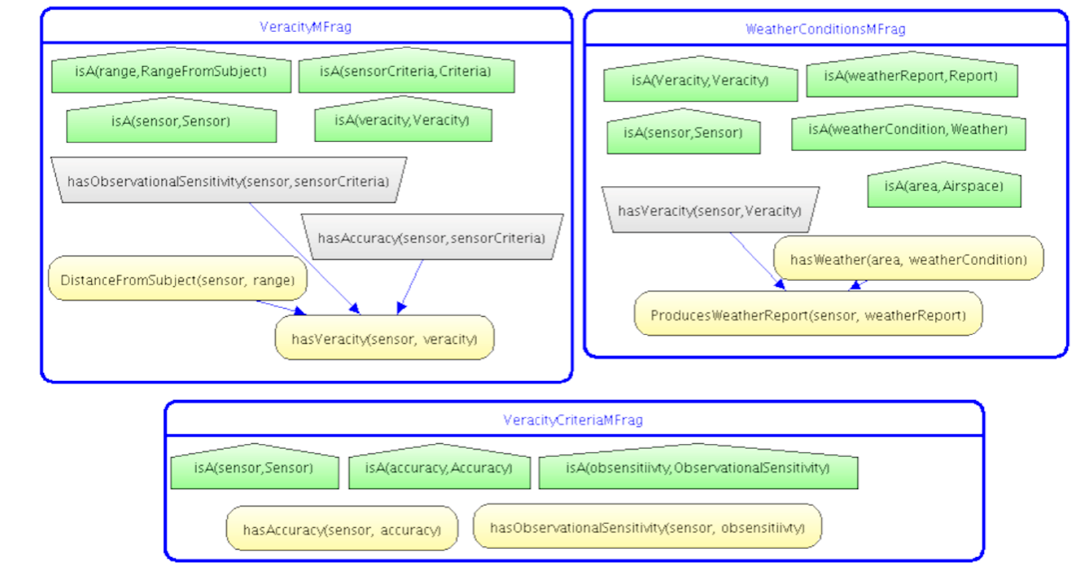
Figure 9. Sample MFrags from the AAO MTheory.